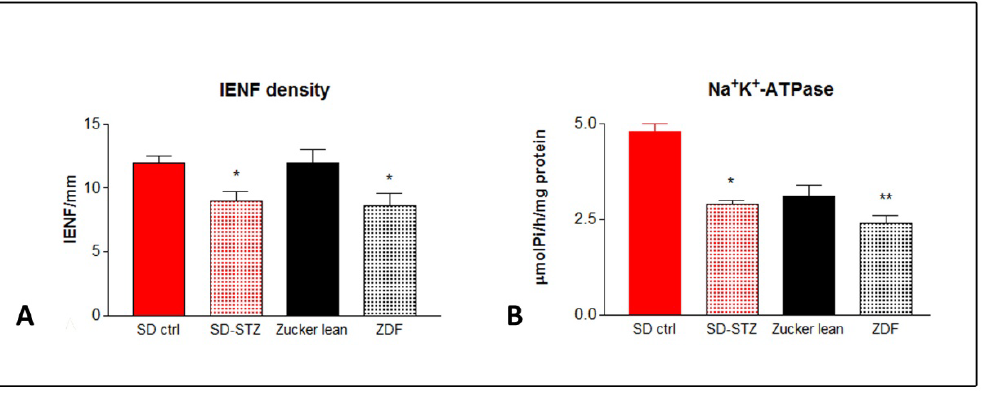
Figure 5. Changes in intraepidermal nerve fibre density (IENF) ( A ) and in Na+/K+ ATPase activity ( B ) at the end of the experiment in SD and ZDF rats. Values represent mean +/− SEM (*) = p < 0.001, (**) = p < 0.01.